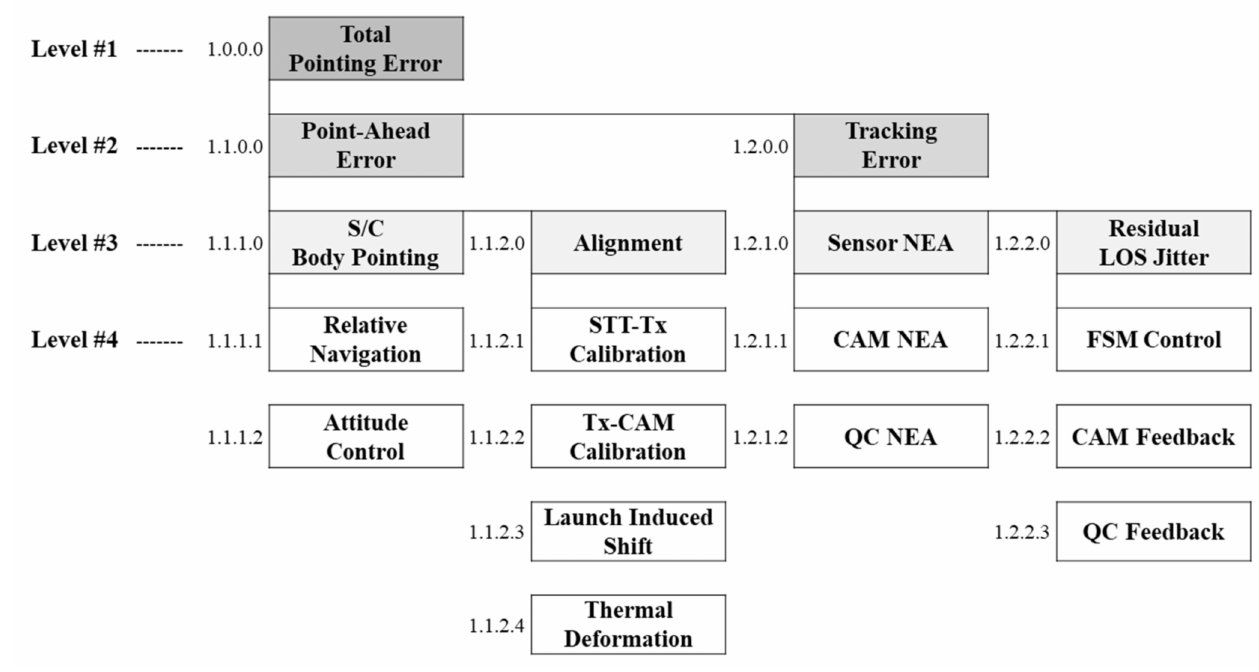
Figure 7. Diagram of the pointing error budget